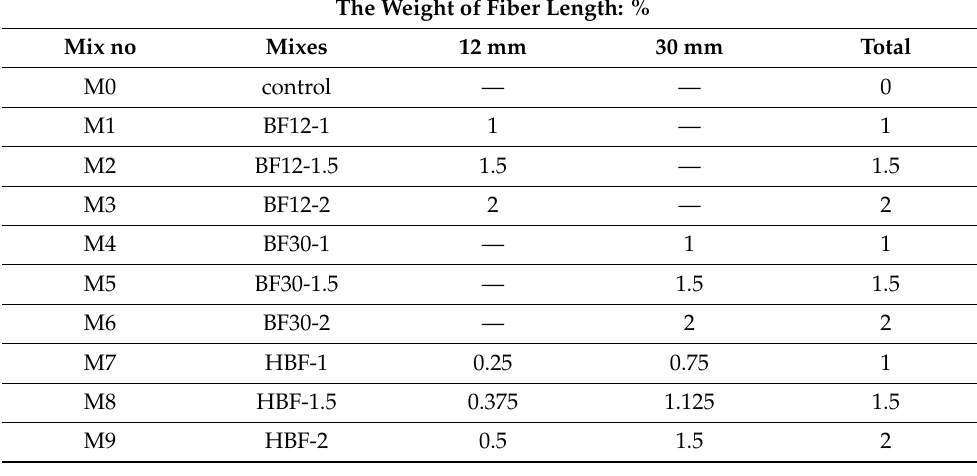
Table 3. Designation of mix composition.